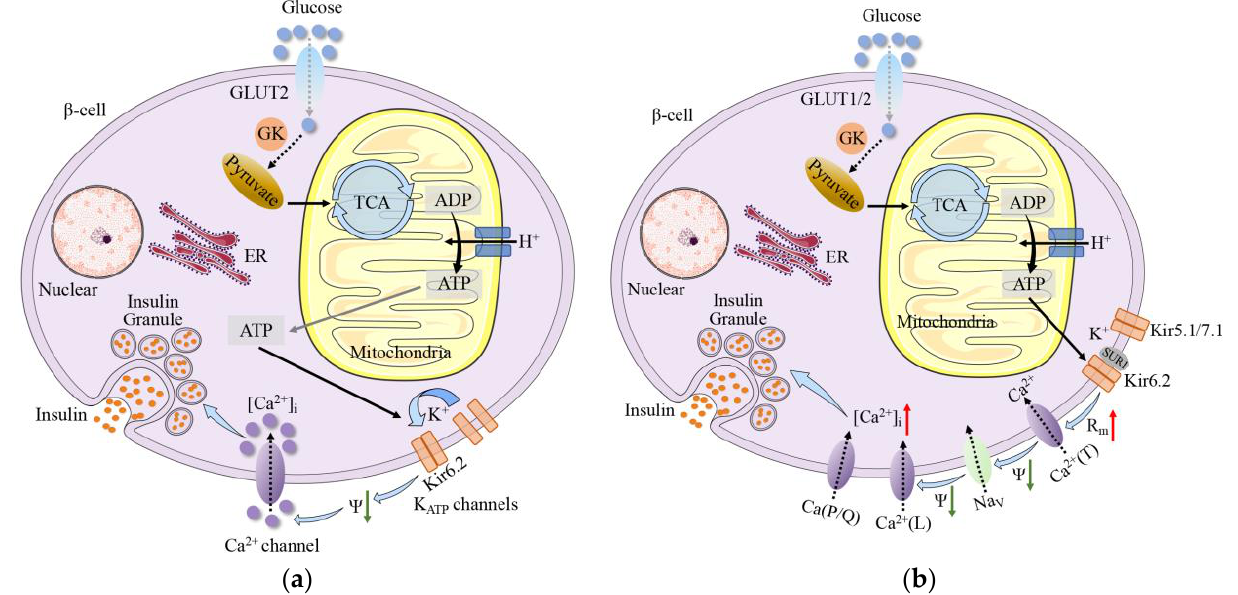
Figure 2. ( a ) The consensus model of GSIS. Glucose is transported into the β -cells via GLUTs. After that, glucose oxidizes and generates ATP, mainly in the mitochondria, through the TCA cycle or the Krebs cycle. Increased ATP/ADP ratio reduces β -cell K ATP conductance, which leads to the depolarization of the cell membrane and initiation of electrical activity. The importance of β -cell electrical activity is that it increases the intracellular Ca 2+ concentration, which is required to trigger insulin secretion; ( b ) Stimulus-secretion coupling in human β -cells. Glucose is transported into the β -cells via GLUT1 and GLUT2 and leads to accelerated mitochondrial glucose metabolism, increased ATP production, and K ATP channels closure (consisting of the pore-forming subunit Kir6.2 and the sulfonylurea-binding protein SUR1). Increased membrane resistance (R m ) due to the K ATP channels closure allows the opening of T-type Ca 2+ channels and a further membrane depolarization. The depolarization activates Na channels and L-type Ca 2+ channels. At the peak of the action potential, P/Q-type Ca 2+ channels open and trigger exocytosis of insulin granules. ER: endoplasmic reticulum; R m : membrane resistance; [Ca 2+ ] i : intracellular Ca 2+ concentration; Ca 2+ (T): T-type Ca 2+ channels; Ca 2+ (L): L-type Ca 2+ channels; Ca 2+ (P/Q): P/Q-type Ca 2+ channels; Na v : Na